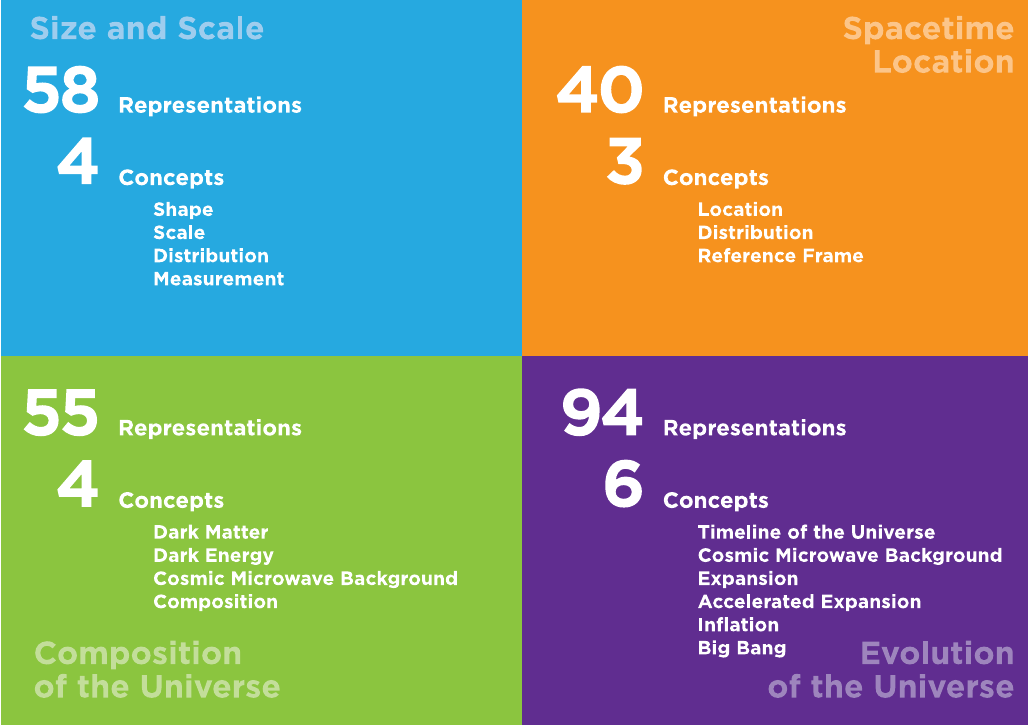
FIG. 8. The landscape of representations in cosmology, showing the number of representations and the various concepts they encompass categorized according to the four dimensions: Size and scale, spacetime location, composition of the Universe, and evolution of the